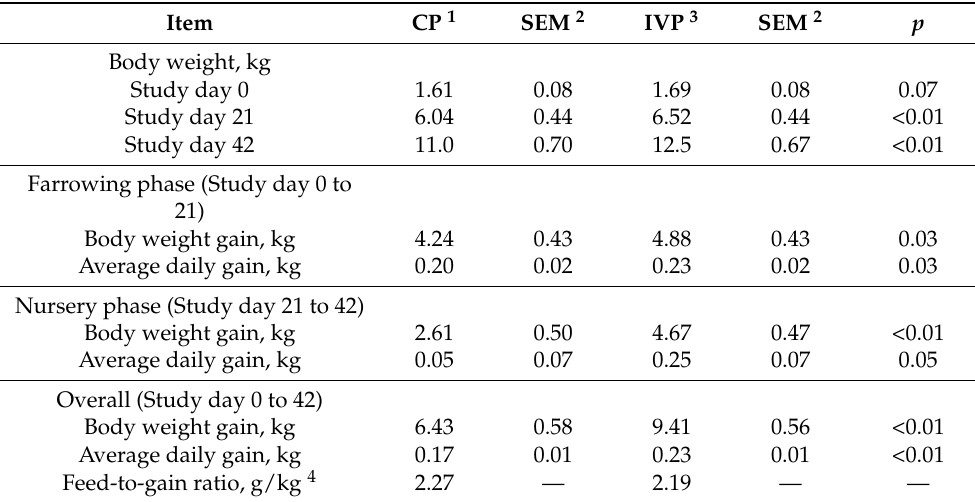
Table 1. Performance of pigs with model adjusted means by treatment groups used to test core antigen bacterin with an immunostimulant on health and performance outcomes when challenged with enteric and respiratory pathogens.